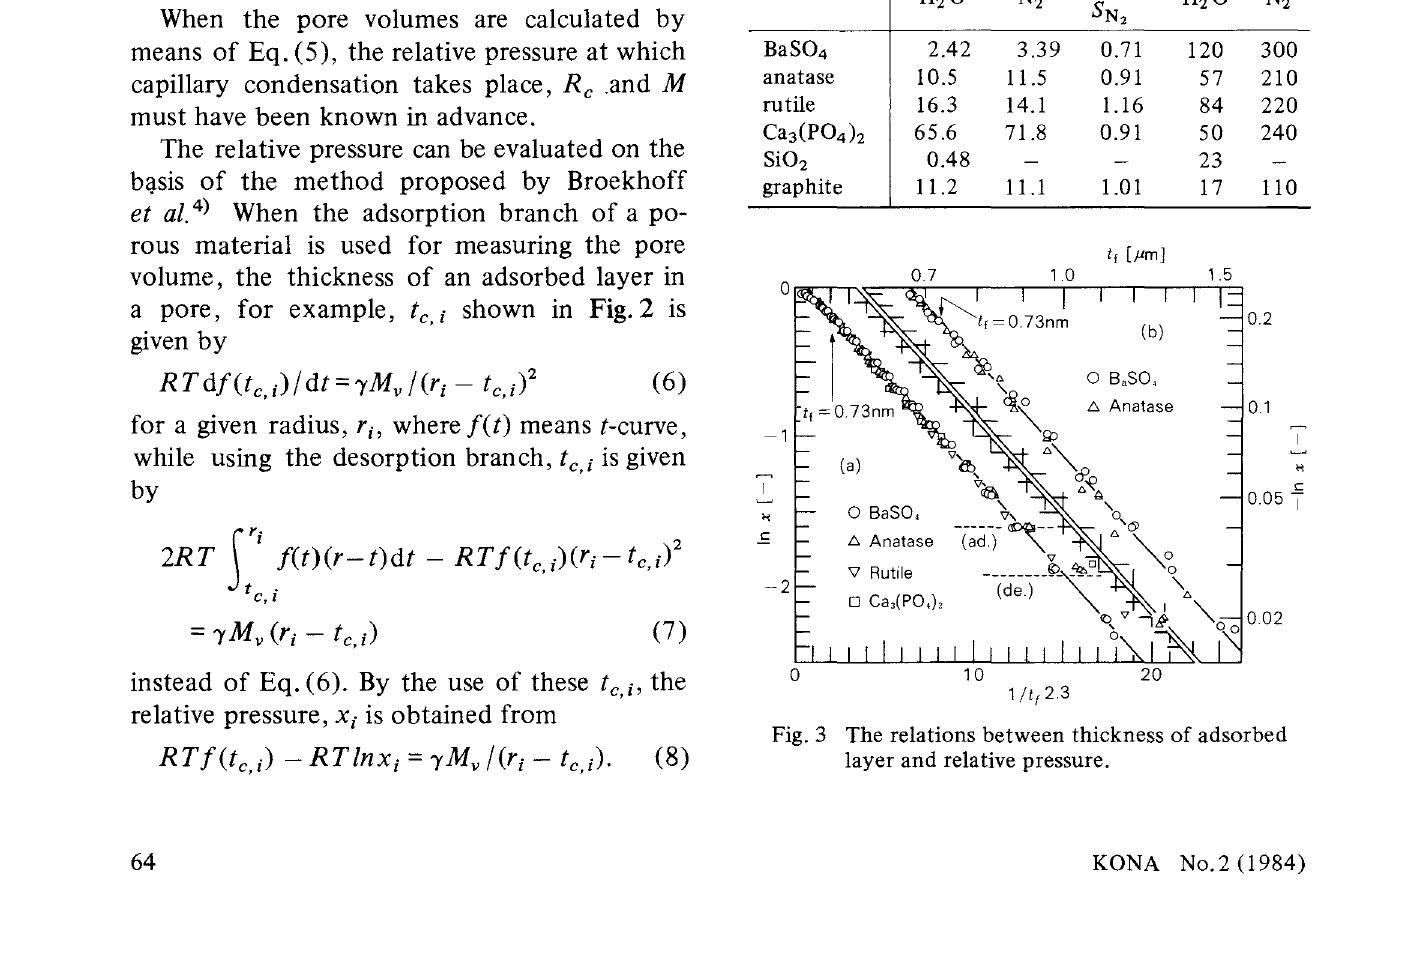
Table 1 Specific surface area, Sand BET's constant C of nonporous materials.